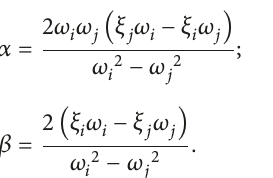
Figure 8: Vertical division of sections on transmission tower num- ber